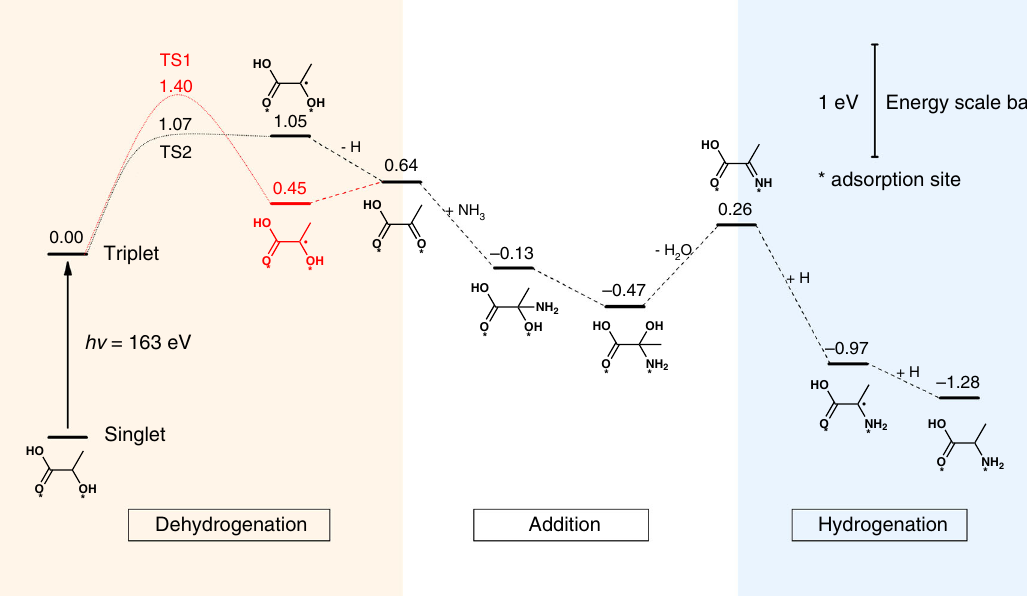
Fig. 5 Density functional theory (DFT) calculations. Energy pro fi les for different reaction steps in lactic acid amination to alanine on CdS as substrate (Supplementary Fig. 8). Thus, the presence of C α – H is essential for the formation of amino acid.